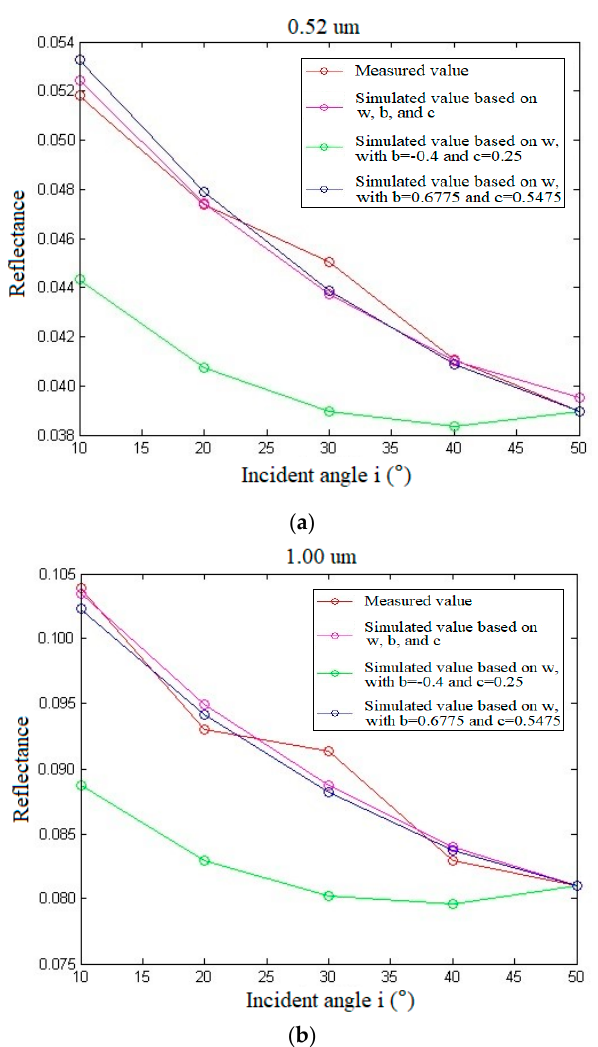
Figure 20. Comparison of the simulated and measured spectra of ilmenite at 0.52 µm ( a ) and 1.0 µm ( b ) versus angle.